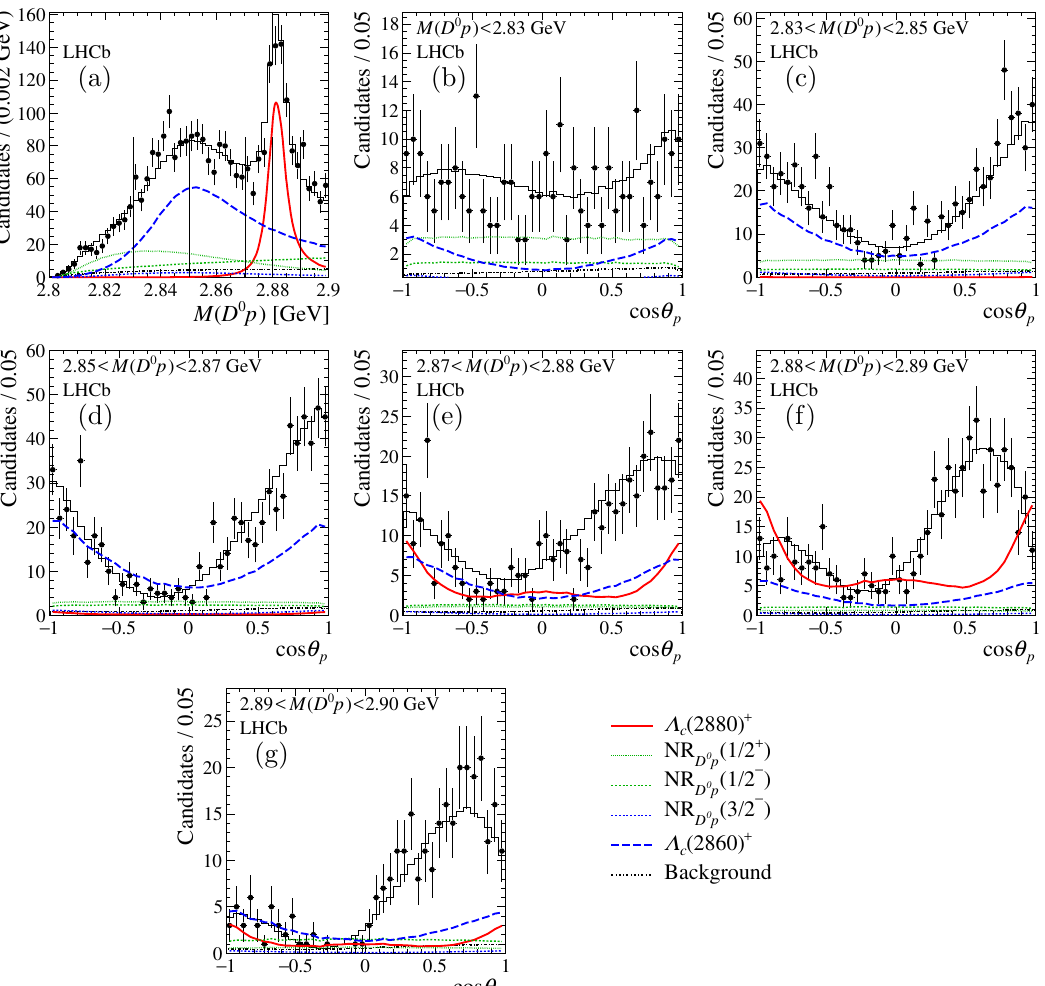
Figure 10 . Results for the (cid:12)t of the (cid:3) 0 ! D 0 p(cid:25) (cid:0) Dalitz plot distribution in the near-threshold b D 0 p mass region (region 3): (a) M ( D 0 p ) projection, and (b{g) cos (cid:18) p projections for slices in D 0 p invariant mass. An exponential model is used for the nonresonant partial waves. A broad (cid:3) c (2860) + resonance and the (cid:3) c (2880) + state are also present. Vertical lines in (a) indicate the boundaries of the D 0 p invariant mass slices. Due to interference e(cid:11)ects the total is not necessarily equal to the sum of the